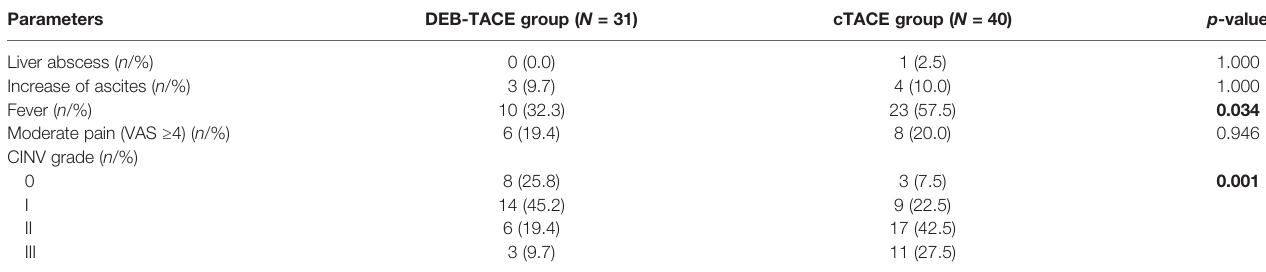
TABLE 5 | Adverse